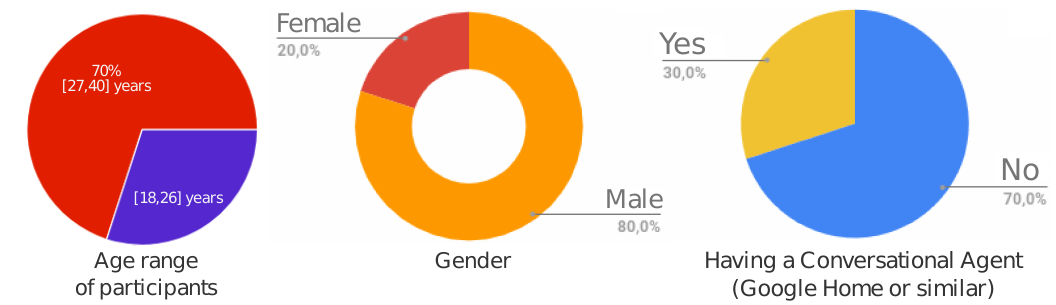
Figure 7. Descriptive analysis of the sample of participants.